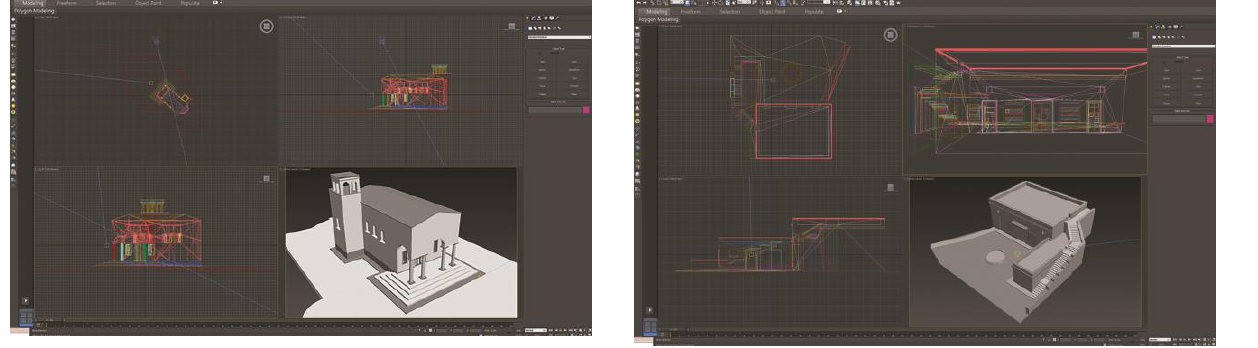
Figure 4. The Royal Park of Tirana. 3D model of the generator house made by the digital platform.